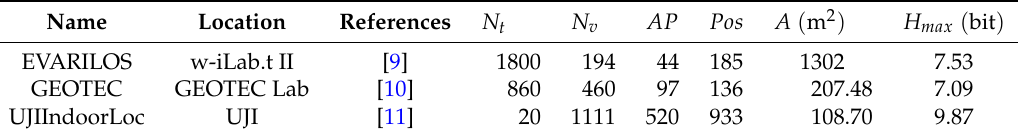
Table 2. Overview of the datasets with N t fingerprints used for training, N v fingerprints used for calculating the results, AP access points, Pos reference locations, A the total floor area and H max the maximum conditional entropy. UJI, Universitat Jaume